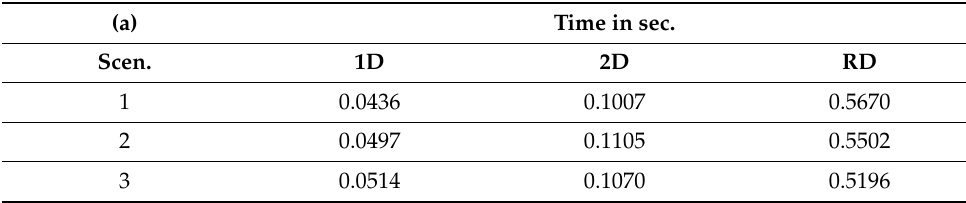
Table 2. Table ( a ) contains the average time needed for calculating the incremental value by each DUPID controller in the considered scenarios (Scen.). In the last column of this table, the relative differences (RD) are given. In table ( b ), the integral of absolute error (IAE) values obtained by the controllers in each scenario are given, and in the last table, ( c ), the relative differences of the obtained IAE values by the controllers are given.